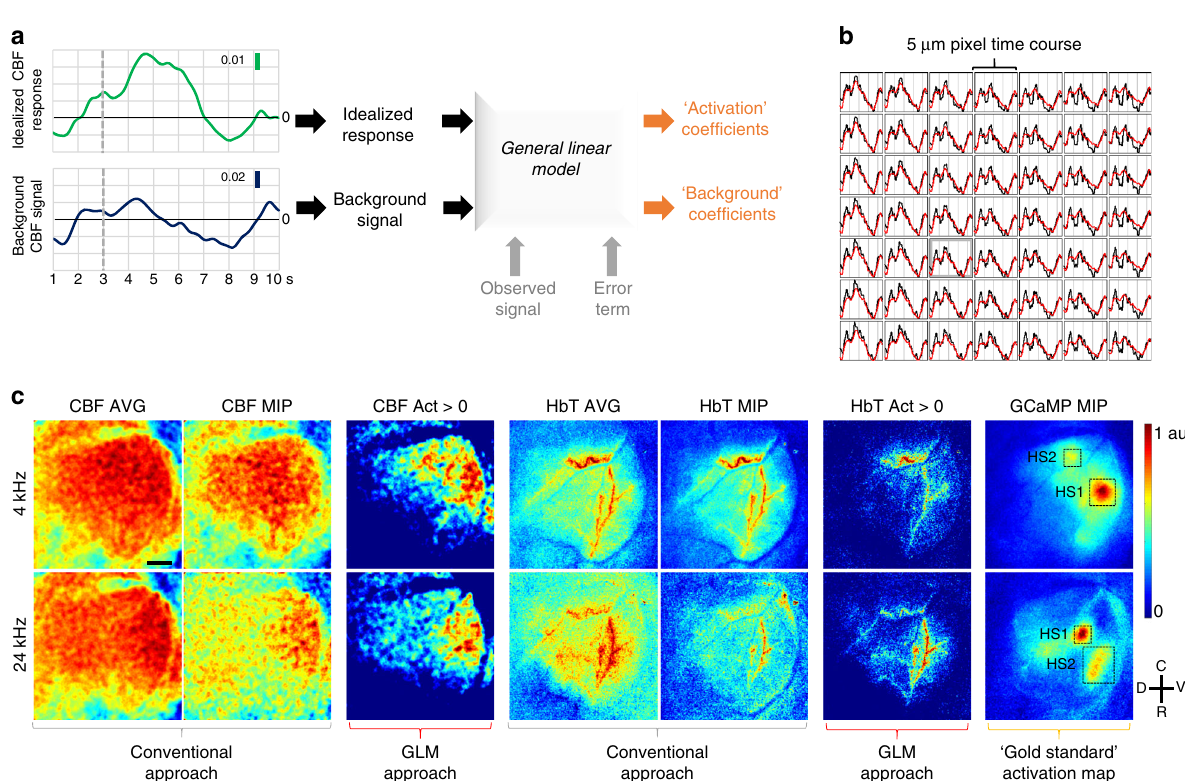
Fig. 4 Wide-area functional mapping analogous to stimulus-based fMRI. a Schematic of the image processing pipeline. The idealized response and the background signal were used as regressors to compute the activation and background coef fi cients from observed time courses using a general linear model (GLM). b AFNI screenshot showing pixel-wise CBF time courses and their corresponding model fi ts (black: observed CBF response, red: model fi t) over a 7 × 7 pixel area. c CBF and HbT average (3 – 7s), maximum intensity projected (3 – 7 s) (MIP) and positive activation coef fi cient (Act) maps for 4 and 24 kHz stimuli. GCaMP MIPs were employed as the gold standard. All maps were normalized to 0.1%. Two GCaMP hot-spots (HS1 and HS2) are marked on each GCaMP map. One can see that the positive CBF and HbT activation coef fi cient maps exhibit more tonotopic speci fi city to the GCaMP signal (i.e., neural activity) than the average or maximum intensity projected CBF and HbT maps. Data presented is an average over 30 trials from a single animal and scale bar indicates 500 μ